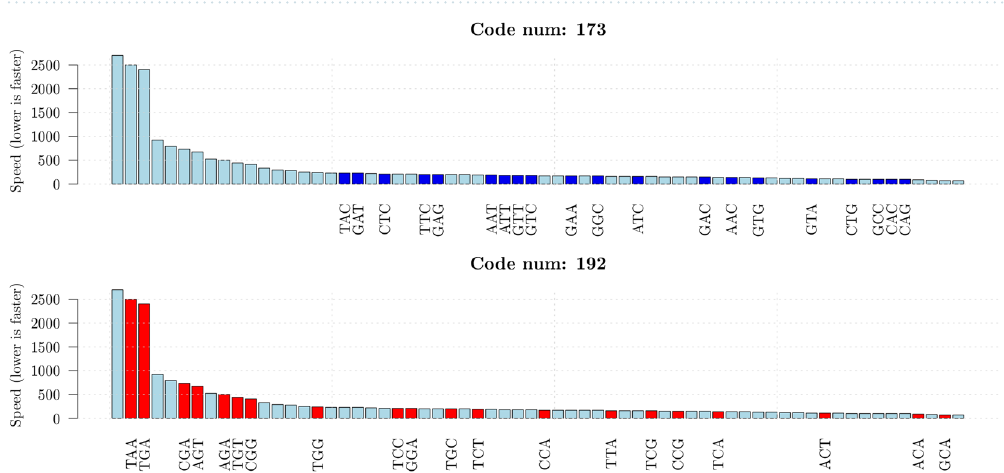
Figure 1. Universal scaling properties of the coverage within equivalence classes for the three reading frames.